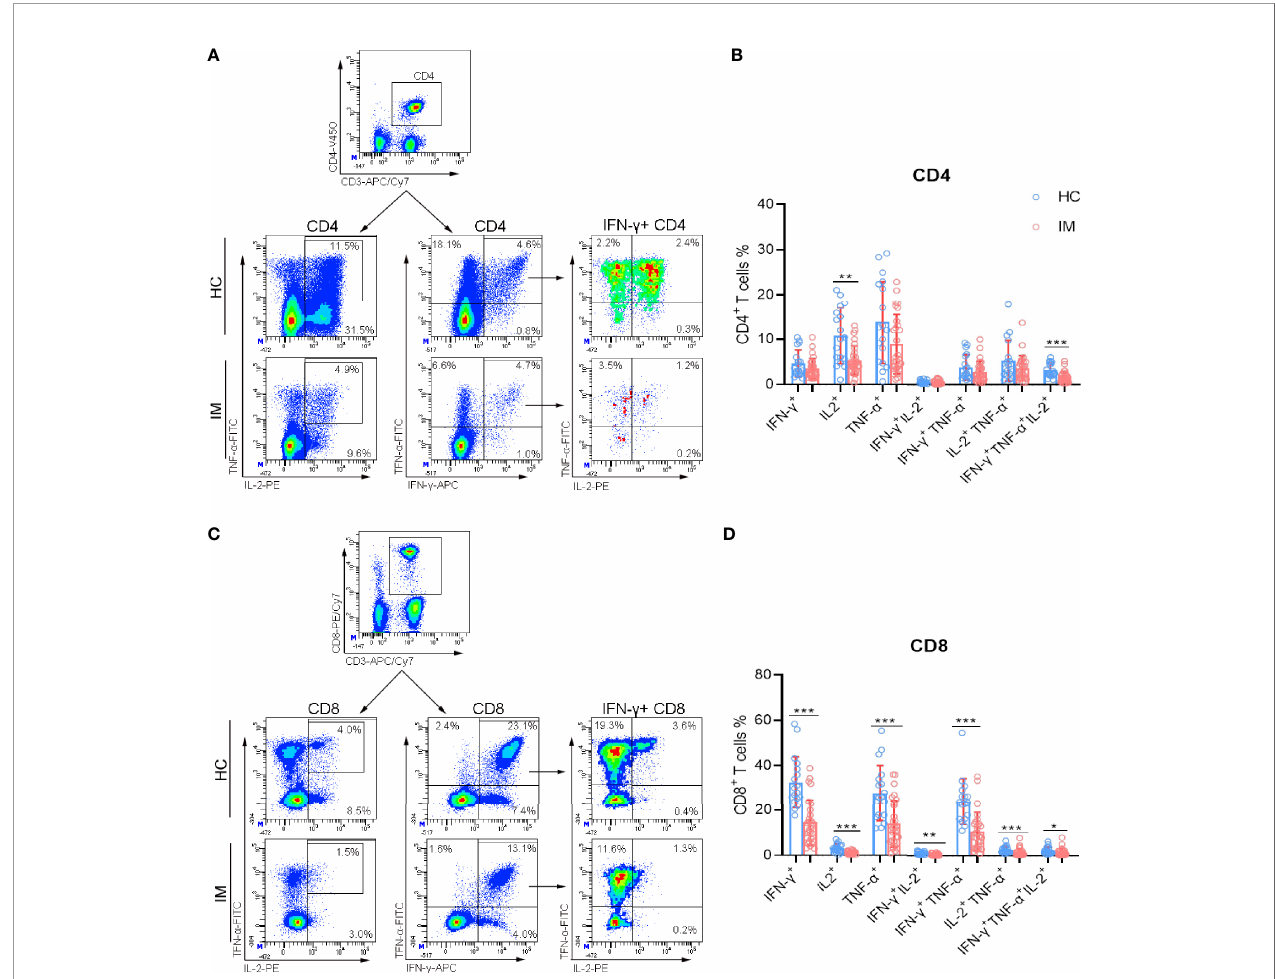
FIGURE 3 | The cytokine secretion capability of T cells. PBMCs isolated from IM patients, and HCs were stimulated with PMA/ionomycin. After culture, the cells were collected and the production of intracellular IFN- g , TNF- a , and IL-2 in CD4 + and CD8 + T cells was analyzed by fl ow cytometry. (A) Representative dot plots showing the gating strategies for intracellular cytokines in CD4 + T cells. CD4 + T cells were shown, and the percentages of IL-2, IFN- g , and TNF- a single-positive, IL- 2 + TNF- a + and IFN- g + TNF- a + double-positive cells were gated. Then IFN- g single-positive cells were shown, and IFN- g + IL-2 + , IFN- g + TNF- a + IL-2 + cell populations were gated. (B) The percentages of IFN- g , TNF- a , and IL-2 single-, double-, and triple-positive cells within CD4 + T cells from IM patients and HCs were expressed as mean with SD. (C) Representative dot plots showing the gating strategies for intracellular cytokines in CD8 + T cells. (D) The percentages of IFN- g , TNF- a , and IL- 2 single-, double-, and triple-positive cells within CD8 + T cells from IM patients and HCs were expressed as mean with SD. Blue circle points represent HCs, and red circle points represent IM patients. * p < 0.05, ** p < 0.01, *** p <